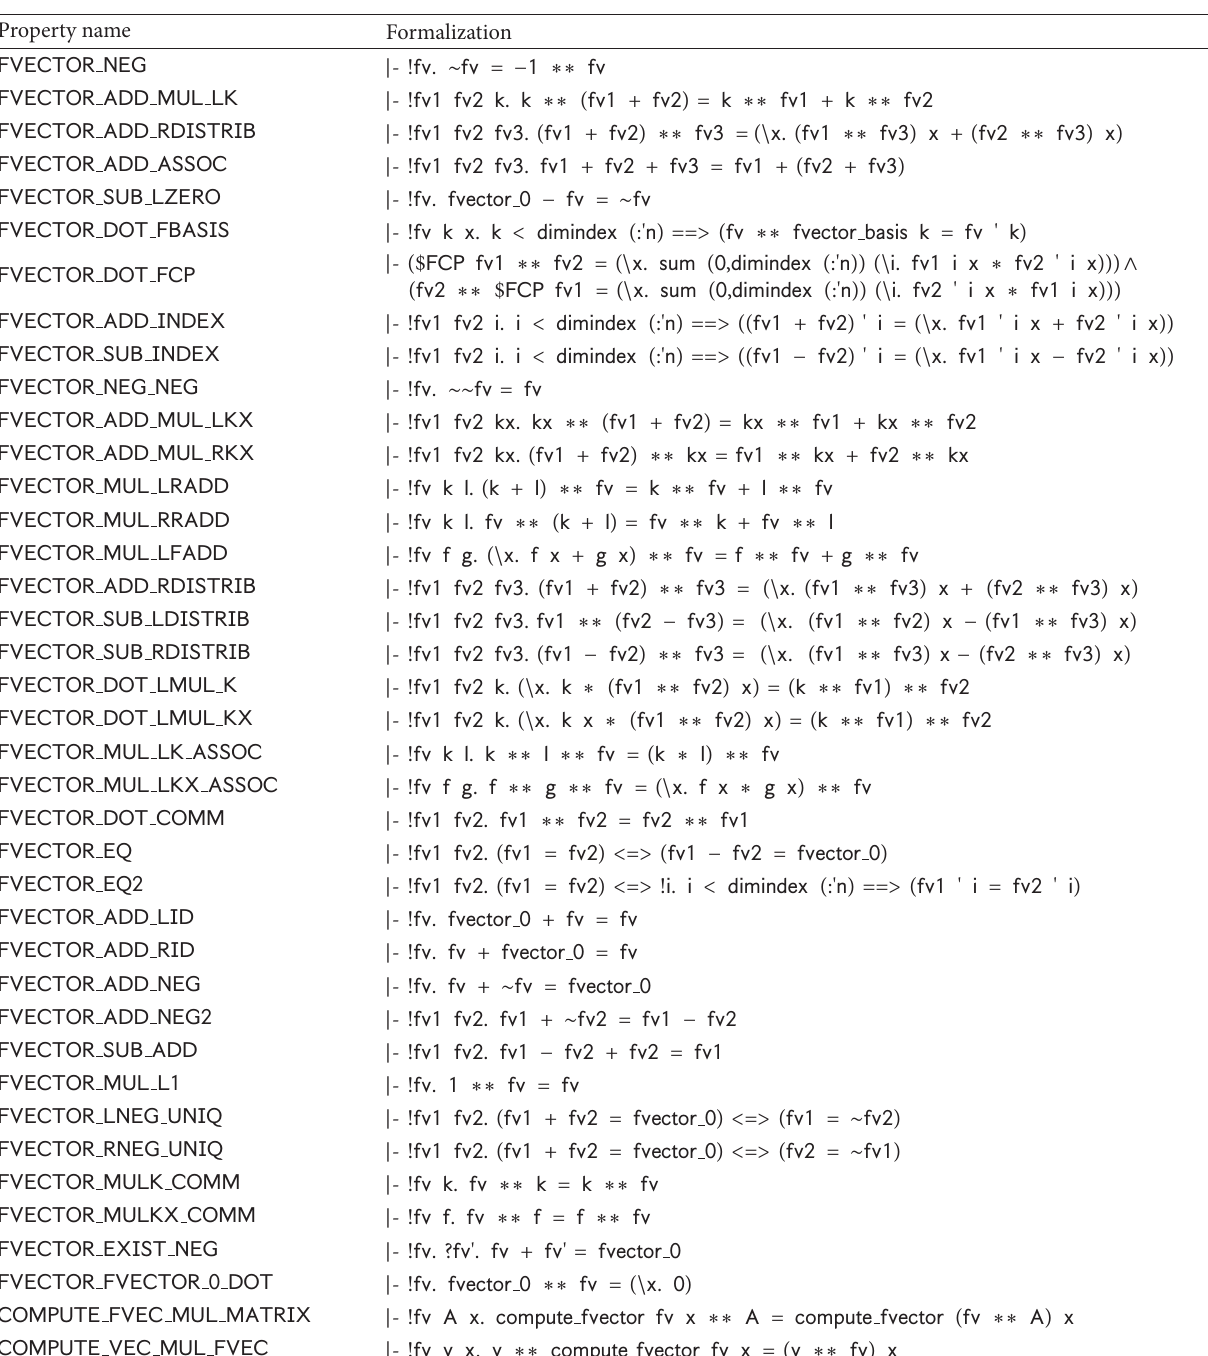
Table 1: Part operations’ properties of function